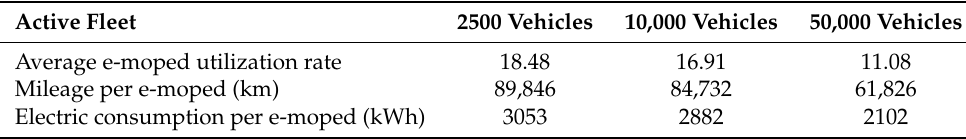
Table 10. Lifetime sharing simulation results for main